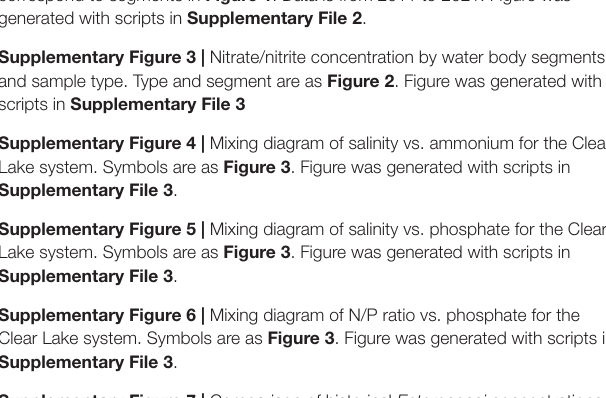
Supplementary Figure 4 | Mixing diagram of salinity vs. ammonium for the Clear Lake system. Symbols are as Figure 3 . Figure was generated with scripts in Supplementary File 3 . Supplementary Figure 5 | Mixing diagram of salinity vs. phosphate for the Clear Lake system. Symbols are as Figure 3 . Figure was generated with scripts in Supplementary File 3 . Supplementary Figure 6 | Mixing diagram of N/P ratio vs. phosphate for the Clear Lake system. Symbols are as Figure 3 . Figure was generated with scripts in Supplementary File 3 . Supplementary Figure 7 | Comparison of historical Enterococci concentrations vs. concentrations following Hurricane Harvey. Symbols are as Figure 3 . Figure was generated with scripts in Supplementary File 3 . Supplementary Figure 8 | Alpha diversity of bacterial communities in the Clear Lake system before and after Hurricane Harvey. Shannon diversity indices were calculated by targeted metagenomic analysis, as described in Methods. Boxes, whiskers and horizontal lines are described in Figure 2 . Sample types are described in Figure 3 . Figure was generated with scripts in Supplementary File 5